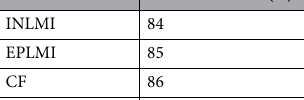
Table 5. Top 100 lncRNA–miRNA pairs prediction ratio.